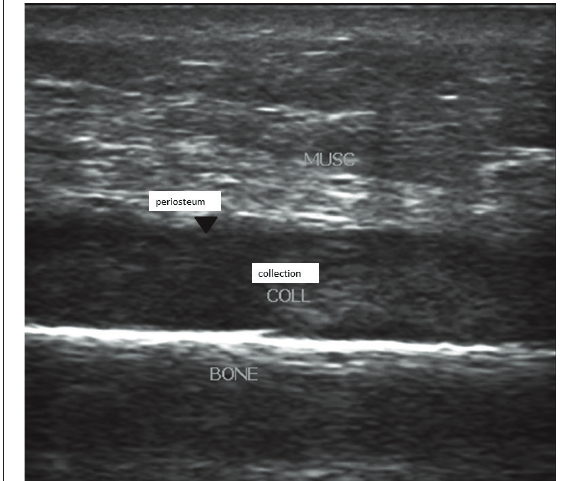
Fig. 5. A patient who required open reduction and internal fixation of a fractured left femur following a gunshot injury. The subsequent development of secondary infection is confirmed on [Tc-99m] white cell scanning. The presence of a fixation device would affect MRI and CT in this